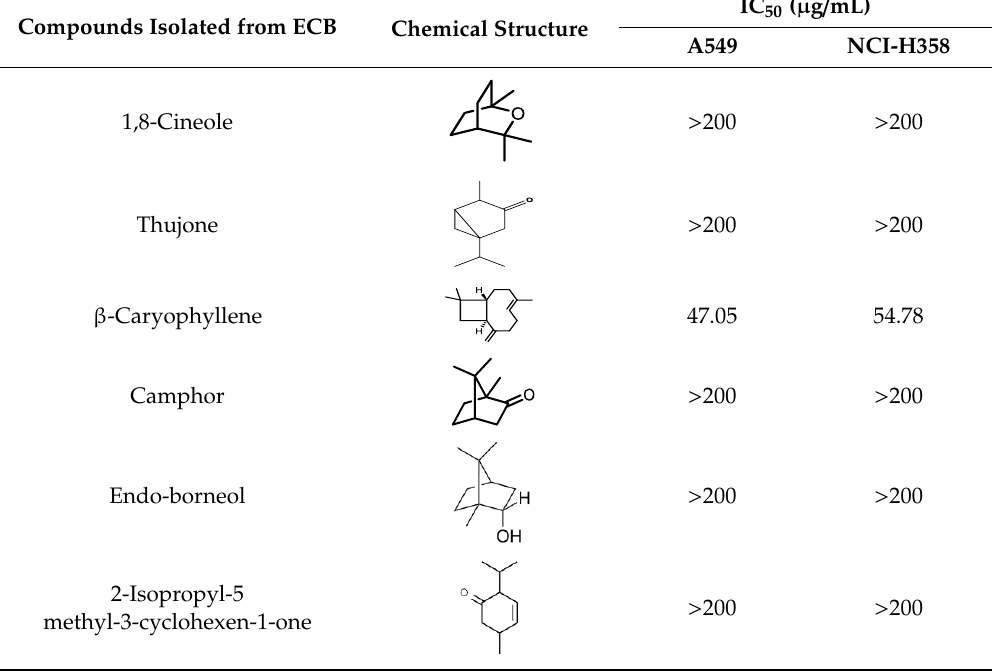
Figure 3. Total ion chromatogram of ECB. Peaks represent: 1. 1,8-cineole; 2. thujone ; 3. β - caryophyllene; 4. camphor; 5. endo-borneol; 6. 2-isopropyl-5-methyl-3-cyclohexen-1-one. Table 1. Cytotoxicity (IC 50 ) of major compounds isolated from ECB, assessed by MTT assay in A549 cells and NCI-H358 cells